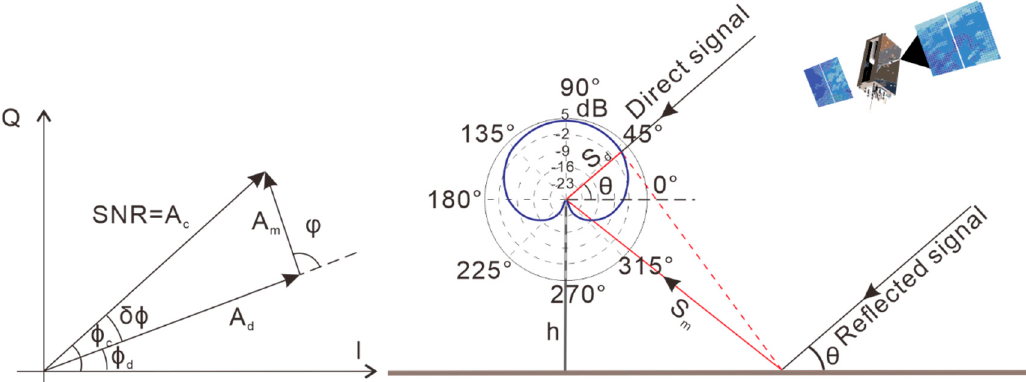
Figure 1. The figure on the left shows the geometric principle of signal reflection. The figure on the right is the principal diagram of the receiver antenna gain interferometry. The left half of the right figure is a diagram of the internal antenna gain (dB) of the receiver at a low satellite altitude angle and relatively low gains of the direct and reflected signals. Thus, the signal-to-noise ratio is small, and the oscillation of the reflected multipath signal depends on the distance difference in the travel distance of the direct and reflected signals to the antenna.